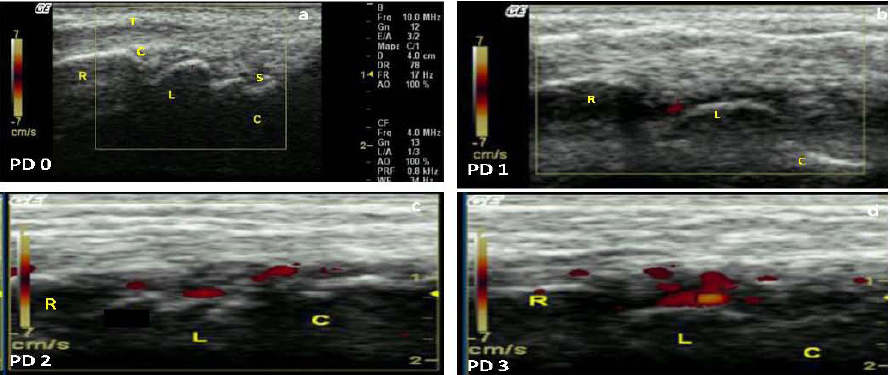
Figure 2. Synovitis identified by power Doppler (PD) ultrasound in a dorsal longitudinal wrist scan. a = grade 0; b = grade 1; c = grade 2; d = grade 3. T = tendon; S = synovitis; R = radius; L = lunate; C = capitate bone; c =